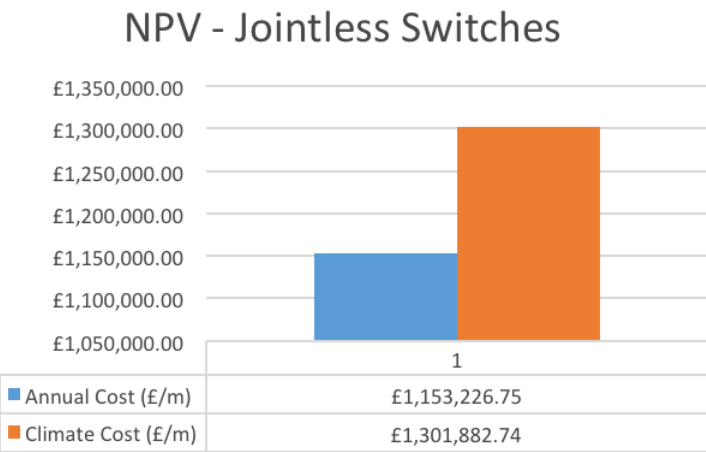
Figure 10. Net present values for jointless switches.